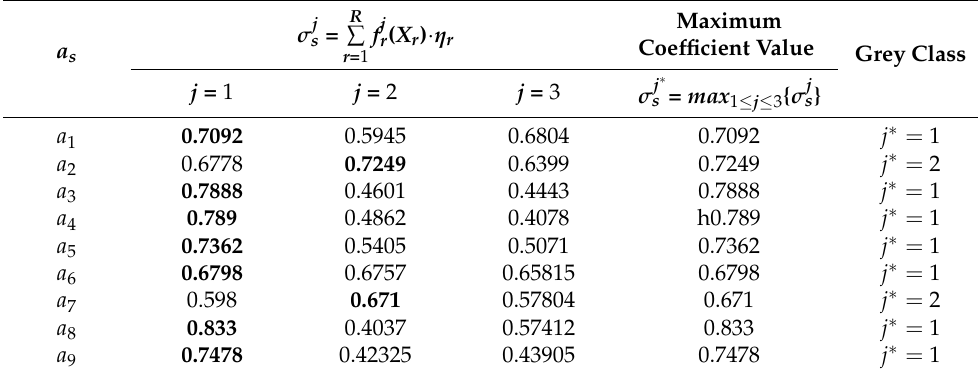
Table 12. The value of the grey fixed weight cluster coefficient for each class weighting.